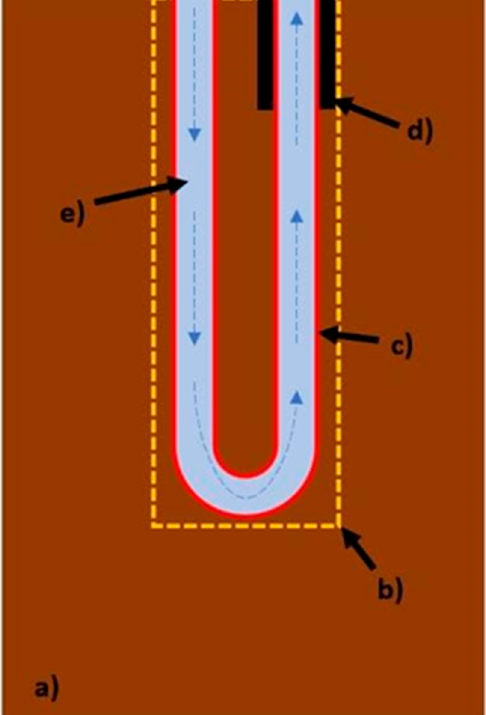
Figure 7. Study domain: ( a ) soil (brown), ( b ) well (yellow), ( c ) heat exchanger walls (red), ( d ) insulator (black), and ( e ) space inside the heat exchanger (blue).